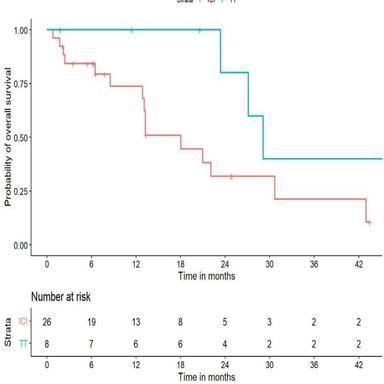
OS of first-line ICI and TT. Overall survival (OS) in months comprises the time from the initiation of treatment to death (from any cause). Estimated median OS in months 1st systemic treatment: ICI: median OS 18.0 months, 95% CI 11.7-24.4; 12-months OS rate: 73.7%; 24-months OS rate: 31.9%; 36-months rate: 21.2%. TT: median OS 29.1 months, 95%CI 24.8-33.4; 12-months OS rate: 100.0%, 24 months OS rate: 80.0%; 36- months OS rate: 40.0%.